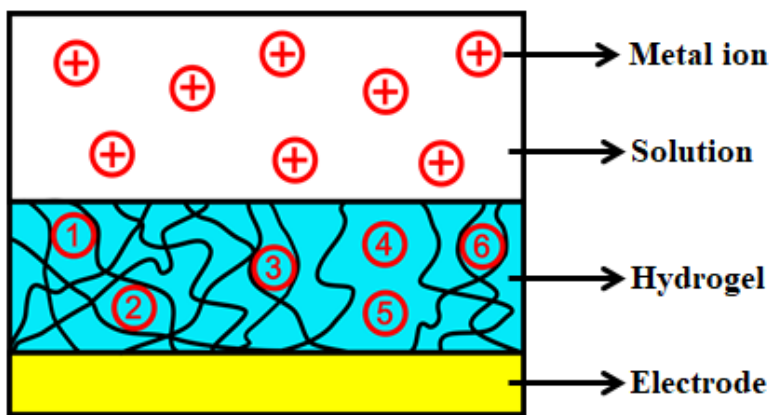
Figure 5. Schematic model to illustrate the adsorption mechanism of the HAMA hydrogel-modified electrochemical device. Red circles ( ⊕ and ① – ⑥ ) represent heavy metal ions.